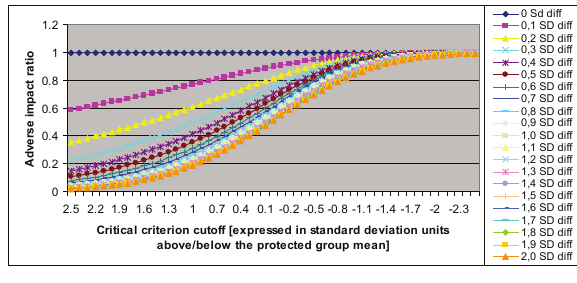
FIGURE 3 Adverse impact ratio as a function of the criterion cut-off in the protected group predicted criterion distribution and the difference in the mean predicted criterion performance: expressed in standard deviation units [ρ xy =0,70]